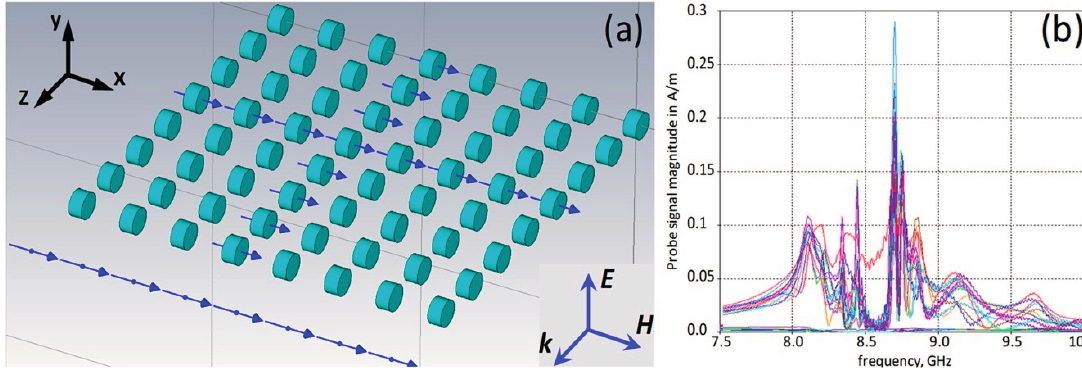
Figure 2. ( a ) DR array infinite due to periodic boundary conditions (PBC) in E-field direction at plane wave incidence along z-axis (arrows show H-field probe locations); and ( b ) spectra of probe signals. DR permittivity is 37, diameter = 6 mm, height = 3